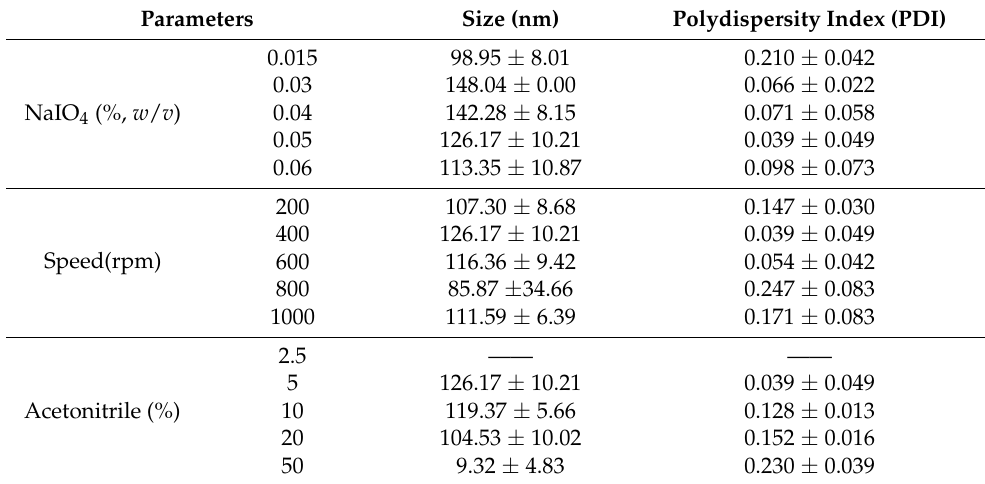
Table 1. Size of polydispersity index of PDH nanoparticles. Parameters Size (nm) Polydispersity Index